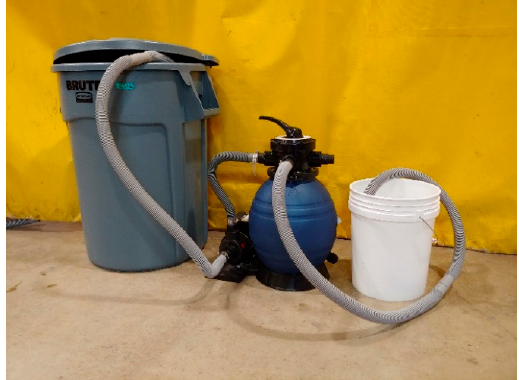
Figure 1. Pump and filter system for sand and sand + carbon filtration treatments.